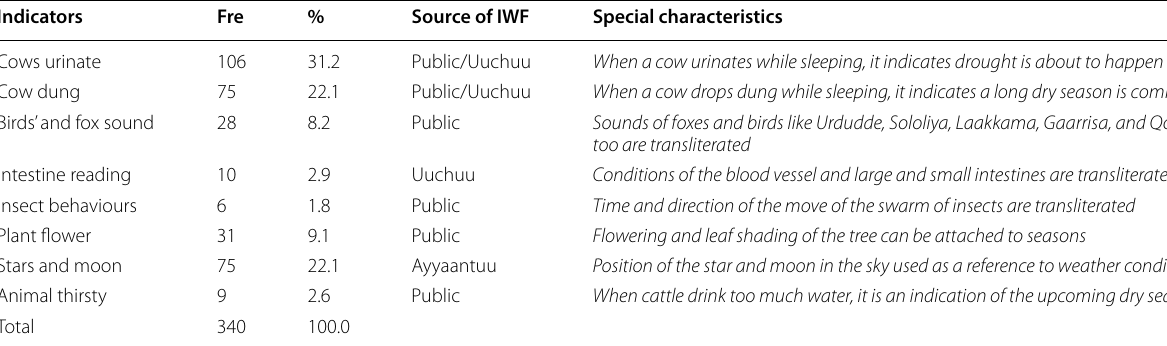
Table 2 Indigenous weather forecasting indicators Indicators Fre % Source of IWF Special characteristics Cows urinate 106 Cow dung